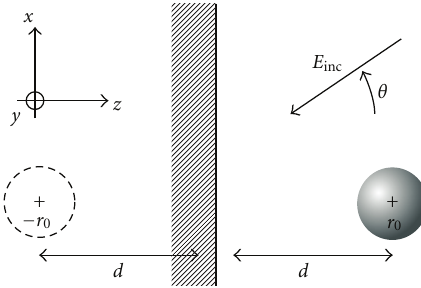
Figure 2: Geometry of the system: A spherical dipole nanoparticle interacts with a perfect mirror. The dashed sphere corresponds to the image